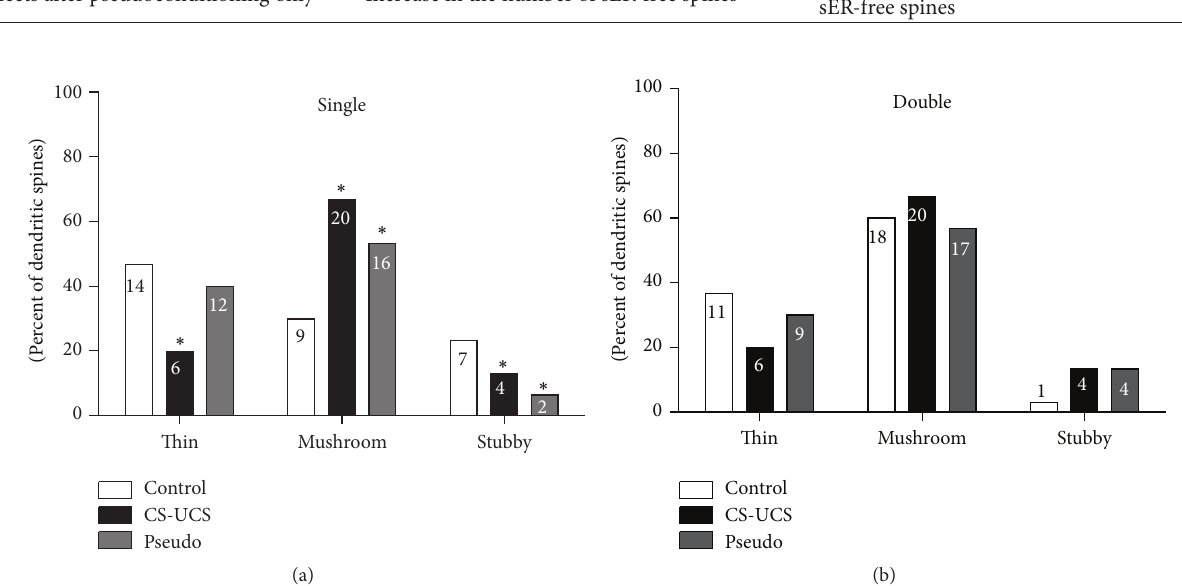
Figure 8: Shapes of single- (a) and double-synapse spines (b): thin, mushroom, and stubby. The graphs show percentages of spine types and their numbers inside the bars (chi square test: ∗ 𝑃 < 0.05